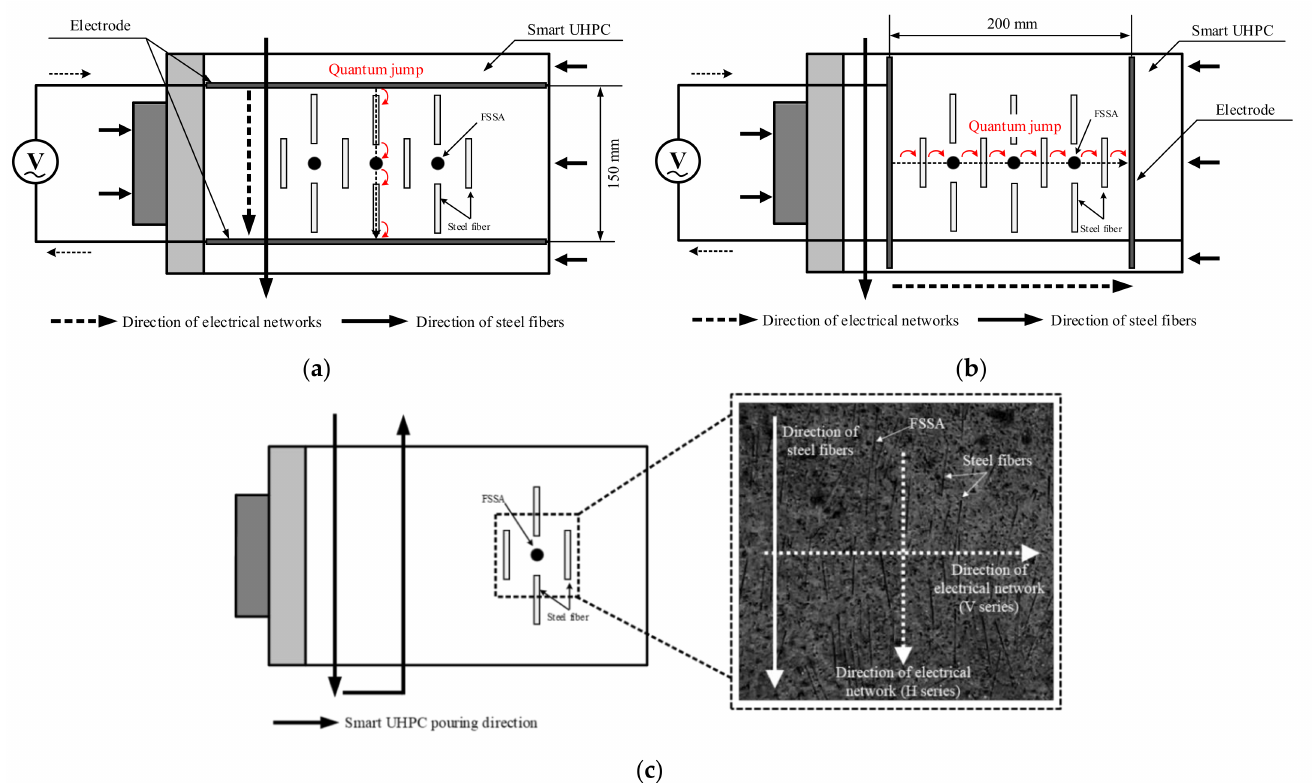
Figure 12. Electrical networks within SCAs: ( a ) H series; ( b ) V series, ( c ) orientation of steel